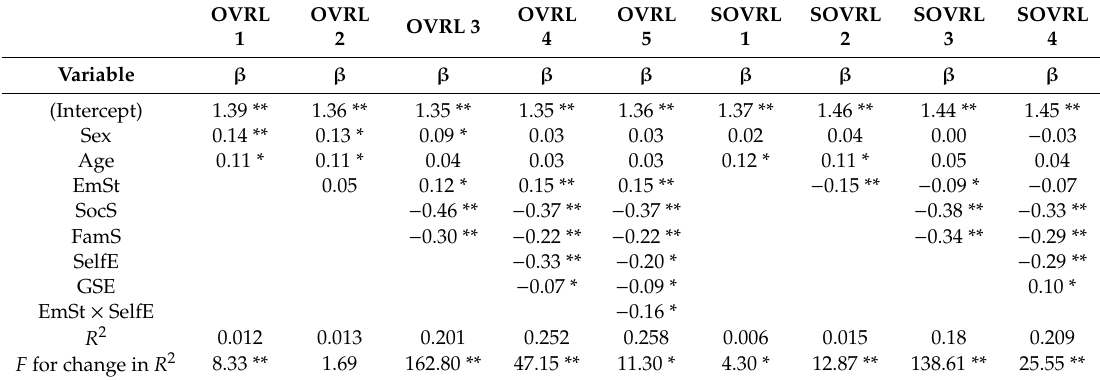
Table 4. Summary of nested regression analysis for variables predicting stress resulting from external demands: stress due to work overload (OVRL) and stress due to social overload (SOVRL) ( N = 1390). OVRL OVRL OVRL OVRL 3 4 1 2